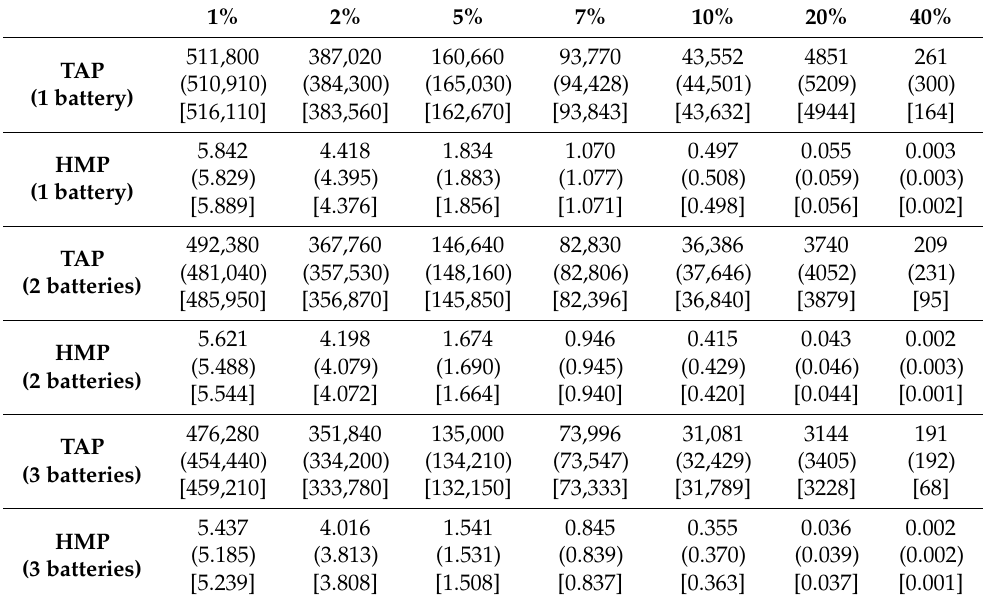
Table 13. Total Amount of Penalty (TAP) and Hourly Mean Penalty (HMP) statistics in EUR referring to real case and theoretical ones: the real data penalty without brackets, the theoretical penalty with Exponential cdf within each round bracket and the theoretical penalty with Weibull cdf within each square